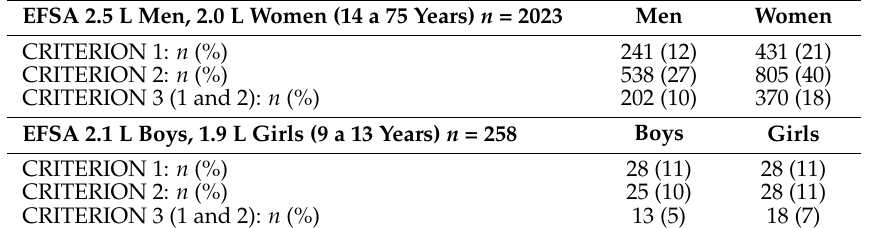
Table 6. Combined classification for the Total water intake (TWI) following established